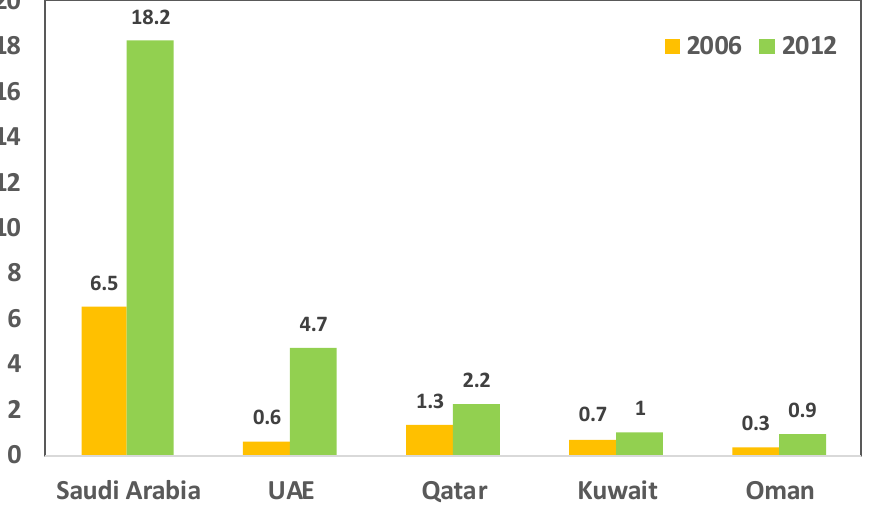
Figure 1. Polymers production capacity (in million tons per annum, MTPA) in the GCC region for the years 2006 up to 2016 [10].